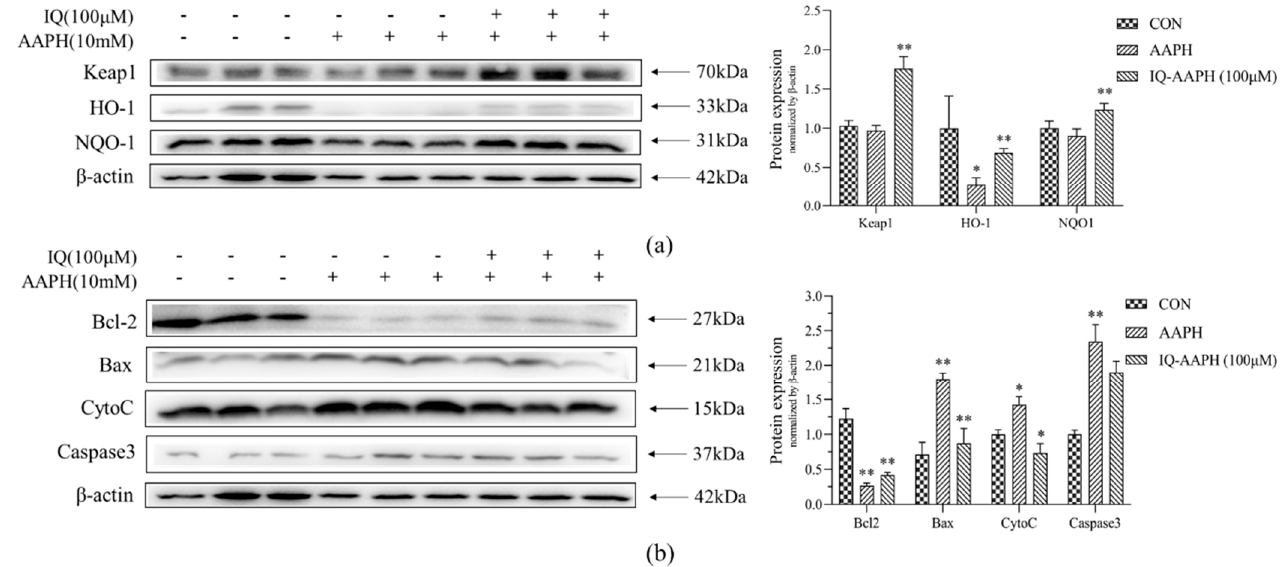
Figure 3. Effect of IQ on AAPH-induced protein expression of MC3T3 cells. ( a ) Protein expression levels of the CON group, AAPH group, and IQ-AAPH group on the Keap1-Nrf2-ARE signaling pathway; ( b ) the protein expression levels of three groups on the Caspase3 signaling pathway. Experiments were performed in triplicate, and the data are expressed as the mean ± SD, * p < 0.05, ** p < 0.01.